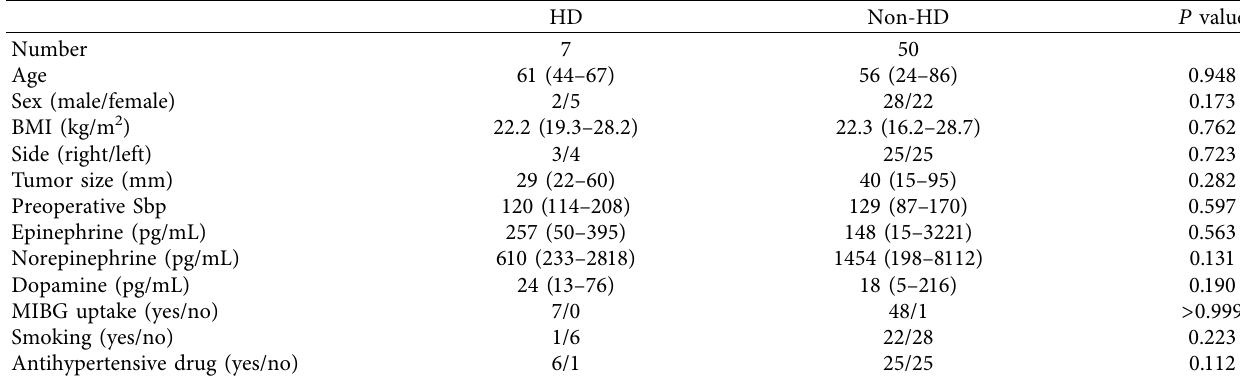
Table 2: Comparison of clinical parameters in the HD and non-HD patient groups.